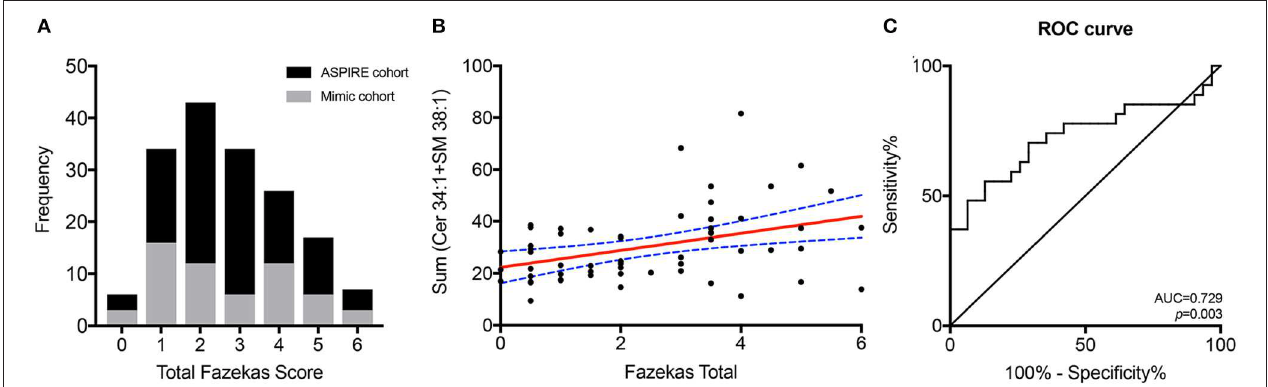
FIGURE 2 | Combined lipid score predicts WMH. The distribution of Fazekas scoring for the total ASPIRE study cohort (black) and the stroke mimic cohort (gray) (A) . Correlation of the combined Cer 34:1 + SM 38:1 lipid score with Fazekas scoring in the stroke mimic cohort (B) . ROC curve for the combined lipid score as a predictor of WMH (C)